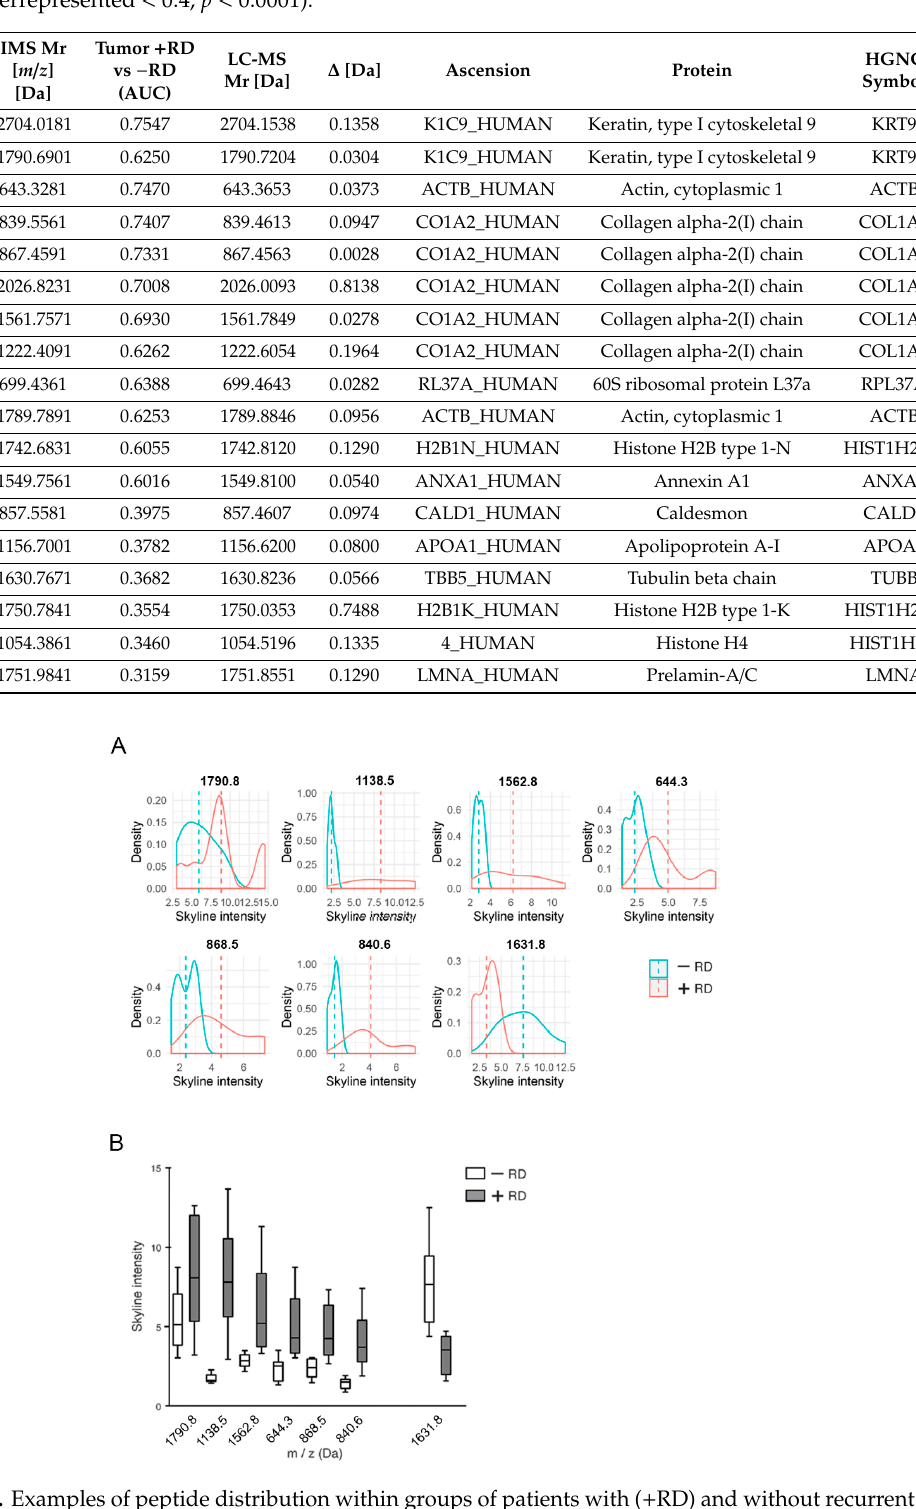
Table 1. Receiver operating characteristic (ROC) curve analysis reveals a prognostic protein signature for early-stage HGSOC. Significantly di ff erentially expressed proteins in primary tumors of patients with recurrent compared with no-recurrent disease are listed (overexpressed, AUC values > 0.6, and underrepresented < 0.4, p < 0.0001).